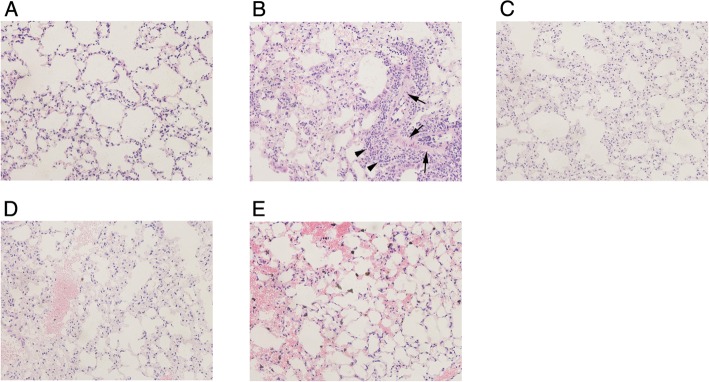
Pathological changes in lung tissue at 12 weeks after radiation in each group. Compared with normal lung tissue (A), pulmonary fibrotic changes (arrow), and infiltration of inflammatory cells (arrowhead) were observed at 12 weeks after radiation (B). Treatment with ulinastatin, methylprednisolone or both effectively delayed the development of fibrosis and inhibited infiltration of inflammatory cells (C–E).